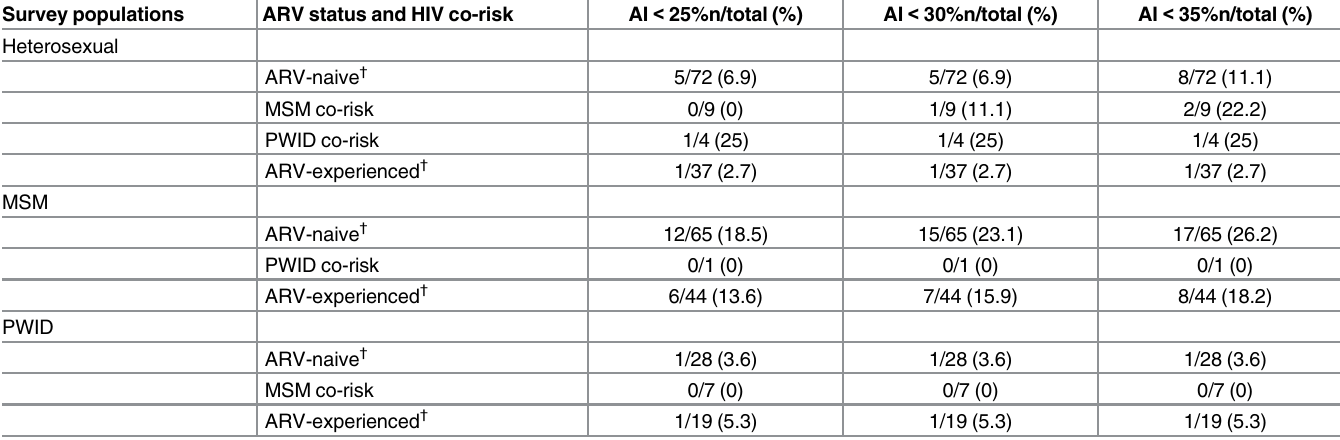
Table 2. Recency test results using, 25%, 30% and 35% avidity indices. Survey populations